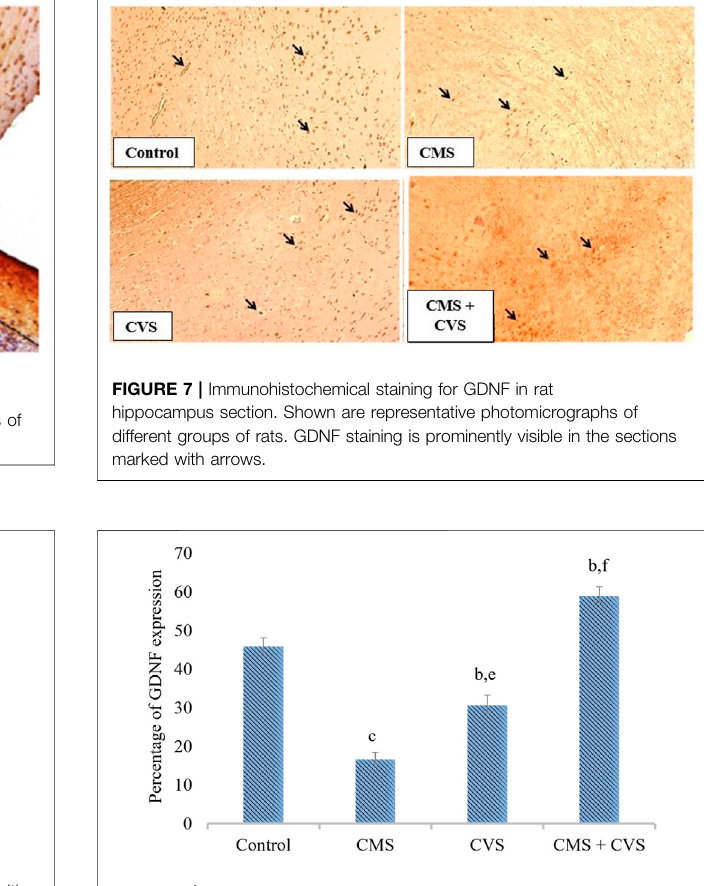
FIGURE8| QuantitativeimmunohistochemicalanalysisofGDNF.Values are expressed as mean ± SEM ( n = 6). b p < 0.01, c p < 0.001 compared with thatofcontrolgroup; e p < 0.01, f p < 0.001comparedwiththatofstressgroup. (One-way ANOVA followed by Tukey ’ s post hoc